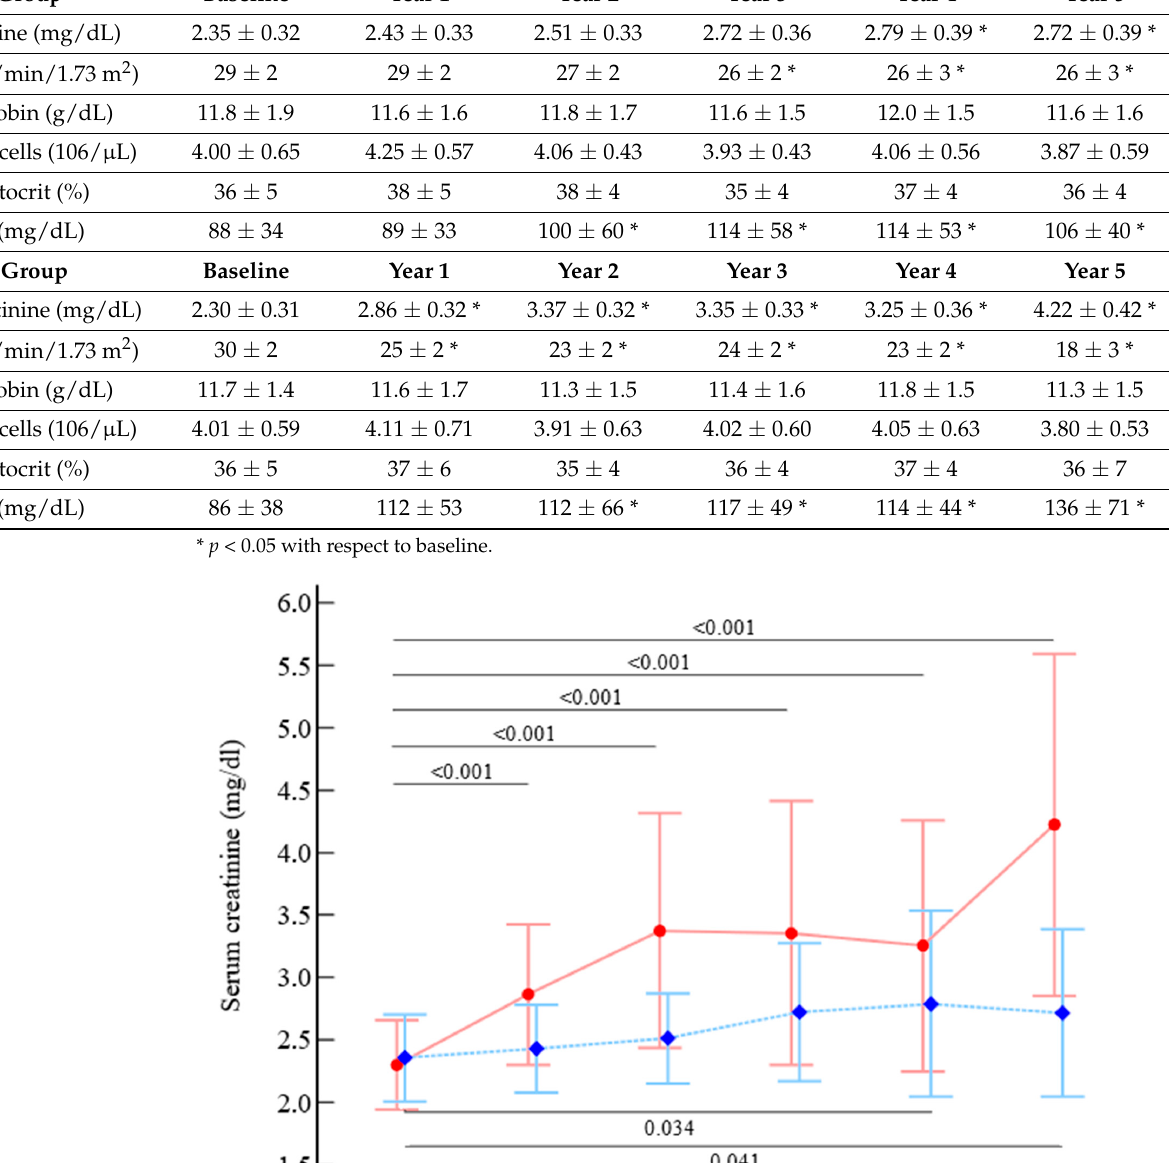
Table 2. Variations in laboratory parameters over time in both groups.